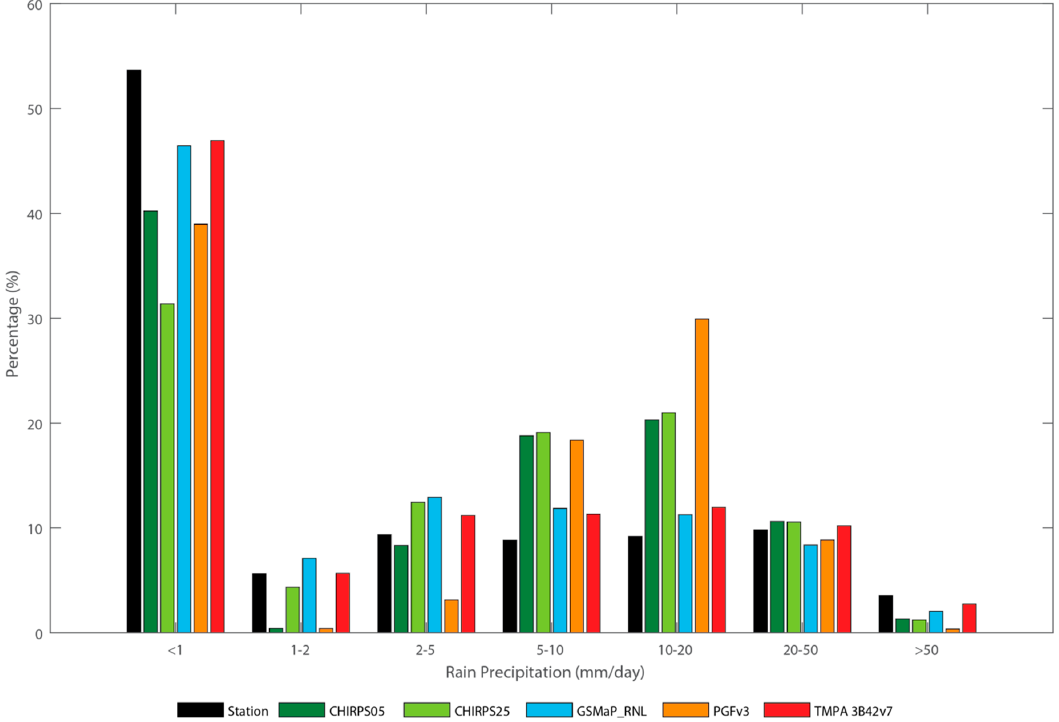
Figure 7. The daily precipitation distribution for different intensity classes over Malaysia from 2008 to 2012 between station data and five gridded precipitation products.